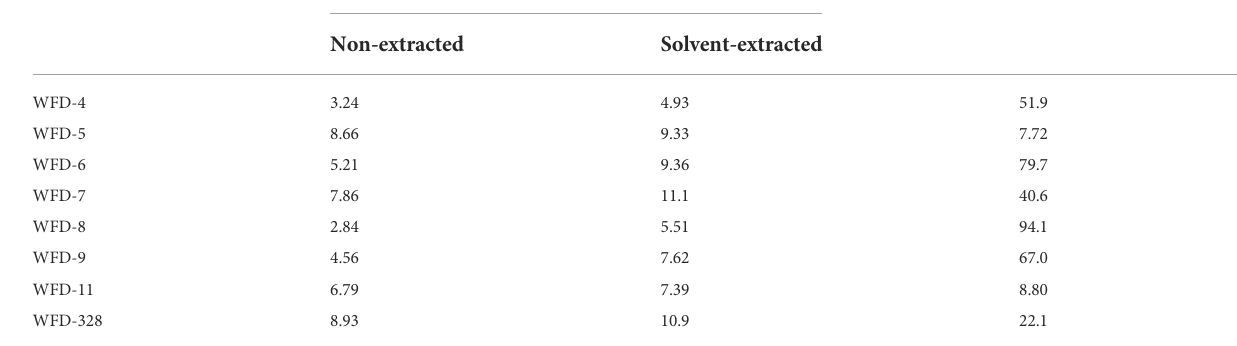
TABLE 3 Porosity before and after solvent